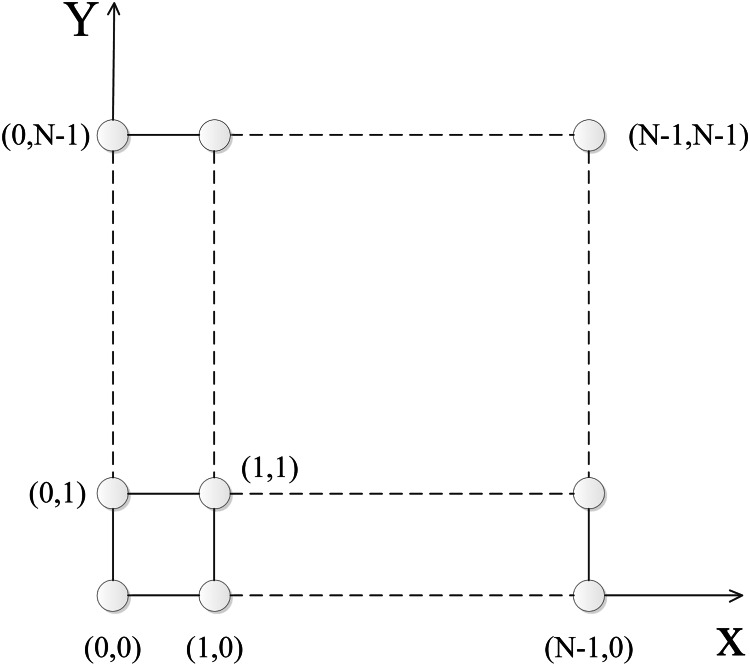
The diagram of TN.